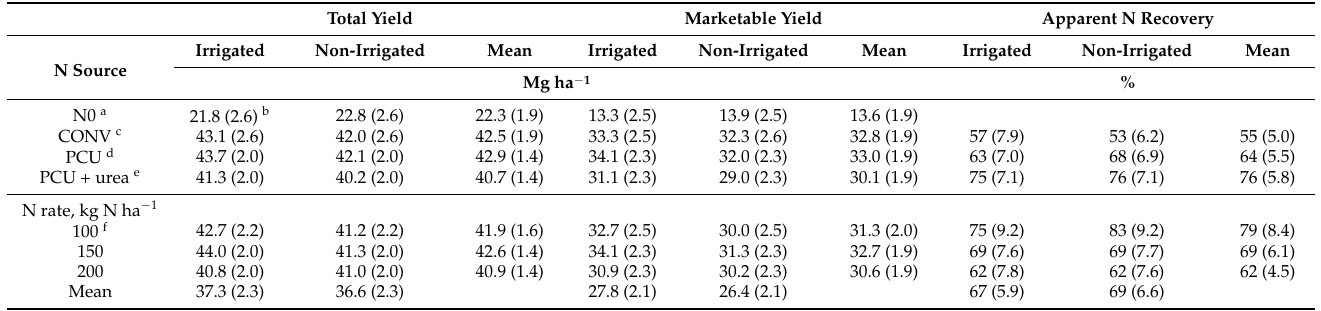
Table 5. Effect of nitrogen fertilization on total and marketable tuber yield, and apparent N recovery. Total